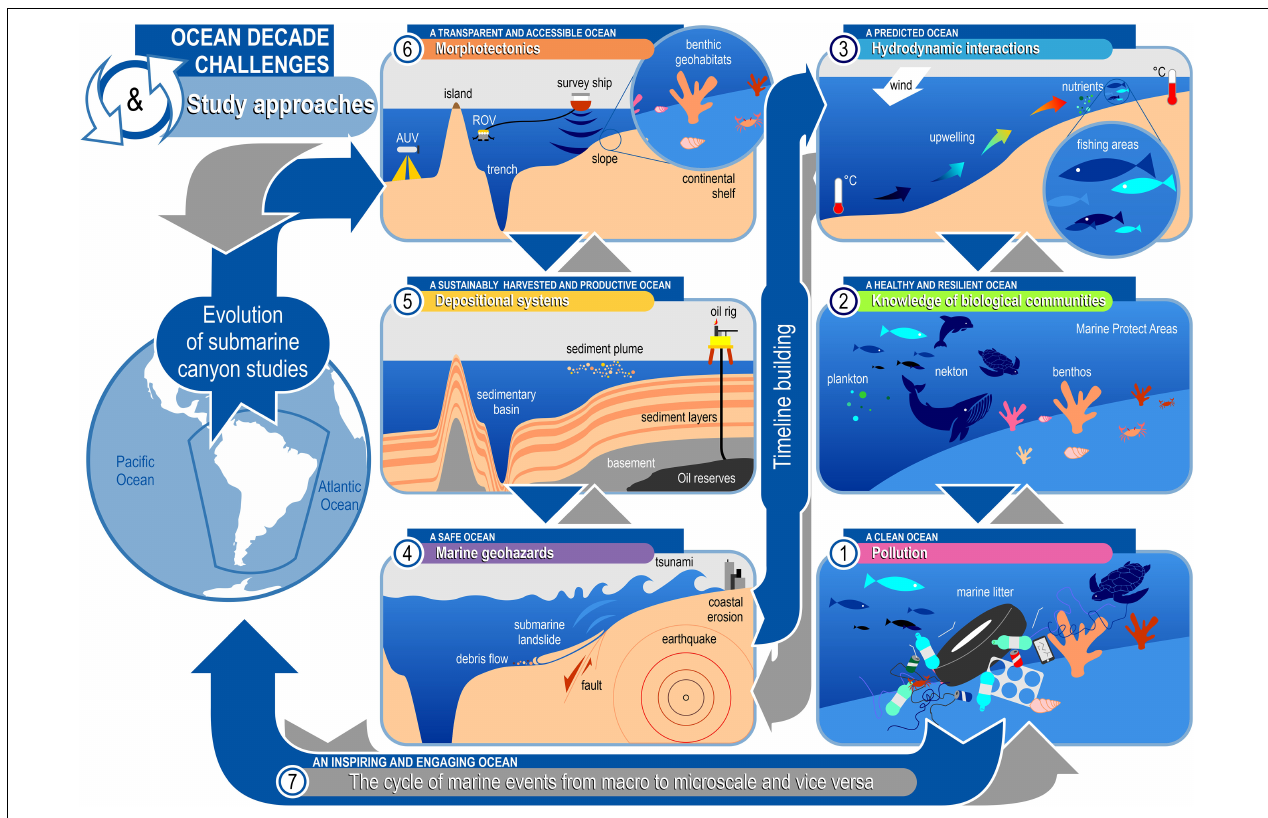
FIGURE 6 | Cycle of marine events following chronological order according to the timeline of submarine canyons studies in South America relative to the Ocean Decade